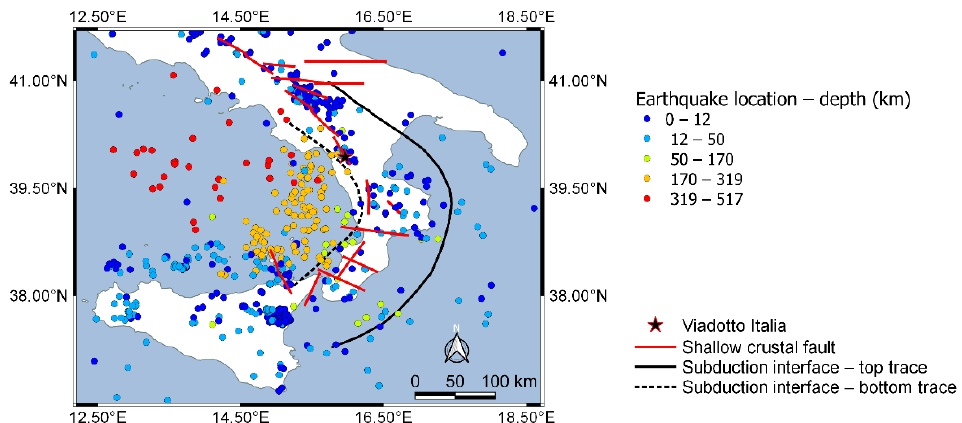
Figure 8. Earthquakes recorded in the Calabria Arc area from the CPTI15 catalog [24] with seismo- genic sources capable of producing M ≥ 6.5 mapped by Zimmaro and Stewart [23] for PSHA appli- cations in the